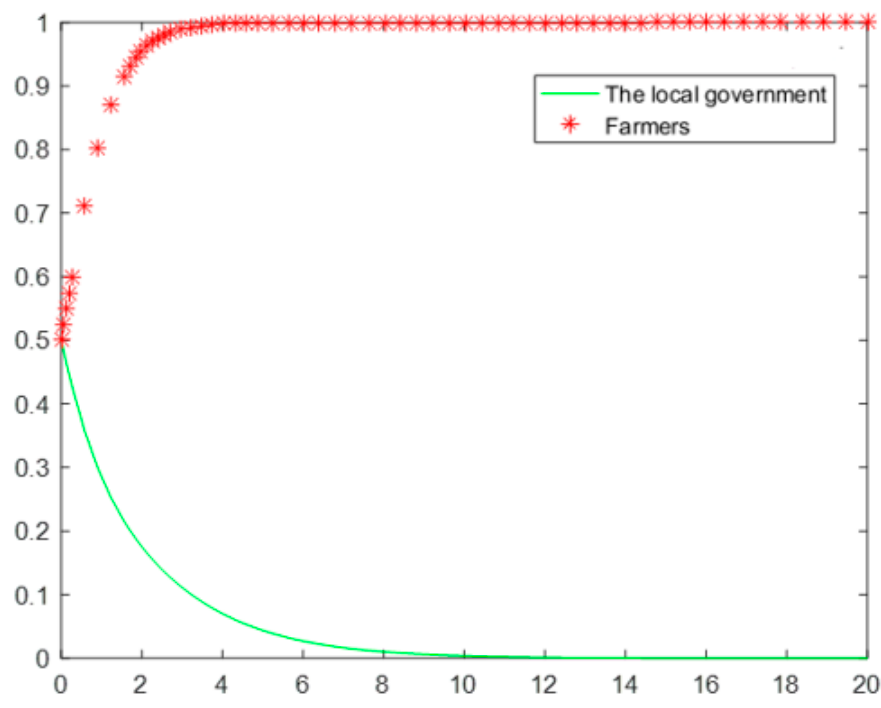
Figure 4. Evolution of strategic choices for local governments and farmers under potential conflict situations (1). claims by